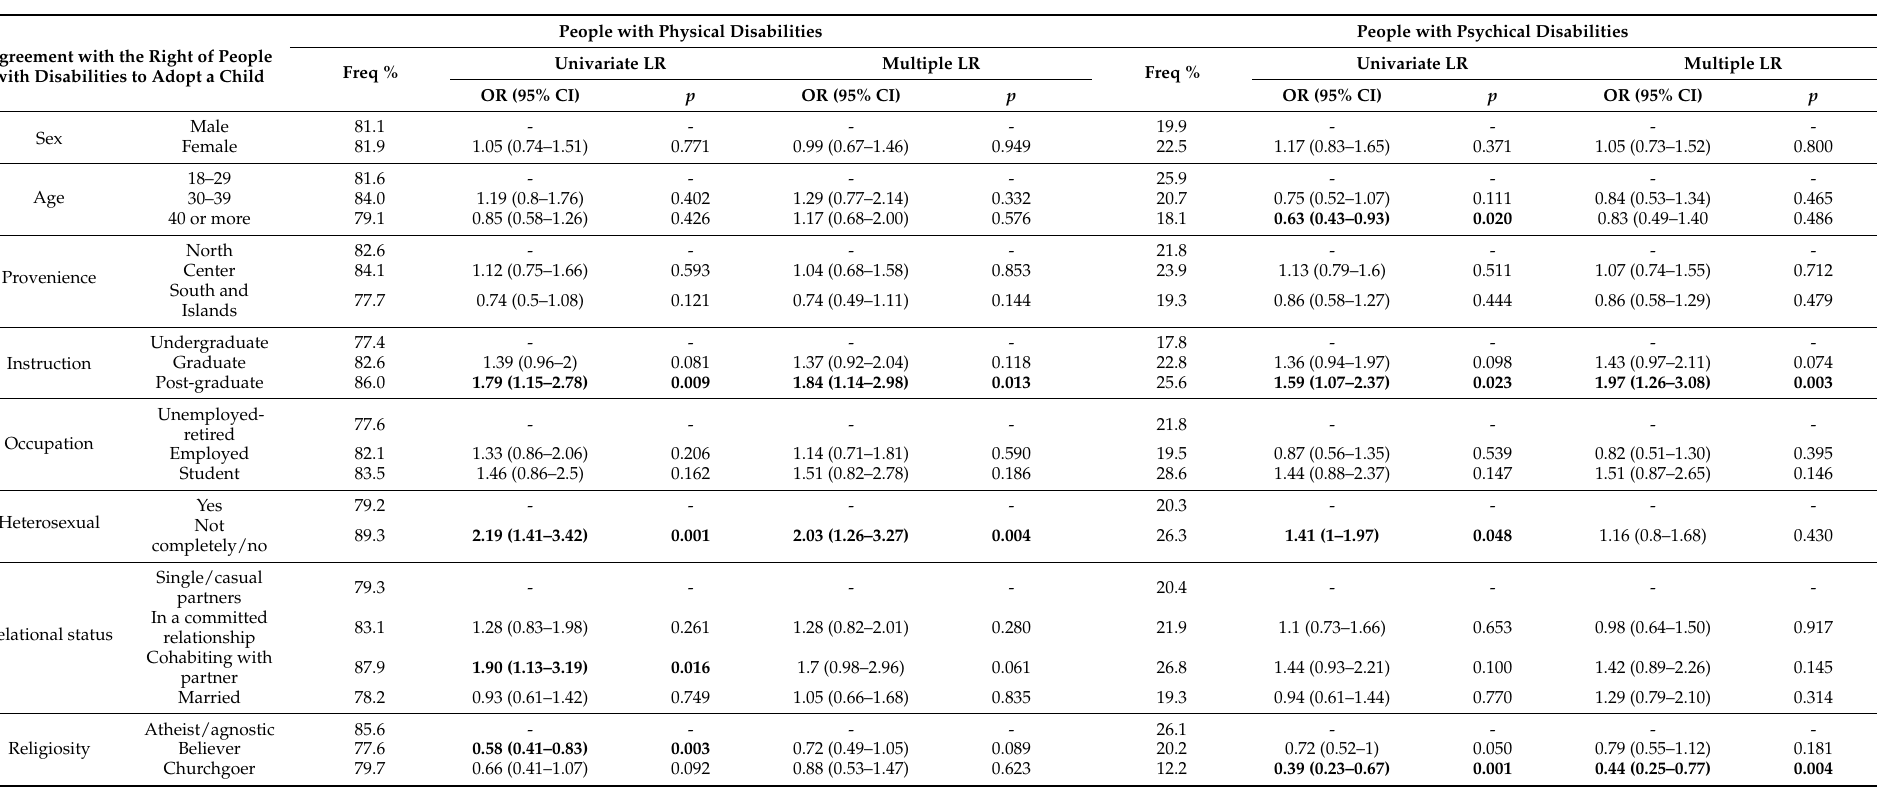
Table 4. Socio-demographic features and percentages of agreement with the right of people with physical and psychical disabilities to adopt a child: frequencies (in percentages) and results of the univariate and multiple logistic regression analyses. Significant differences with respect to the reference are reported in